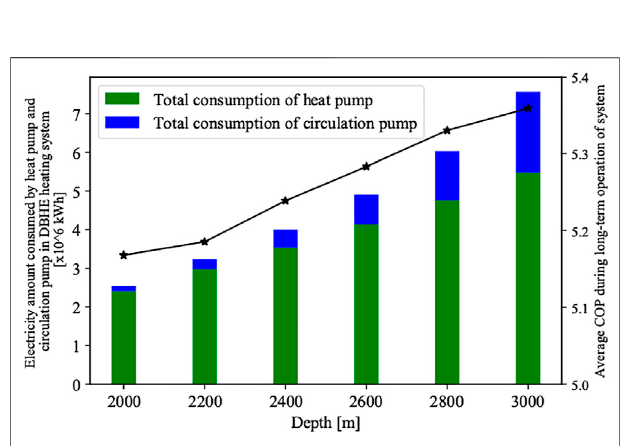
FIGURE 8 | Electricity amount consumed by heat pump and circulation pump in the DBHE heating system.